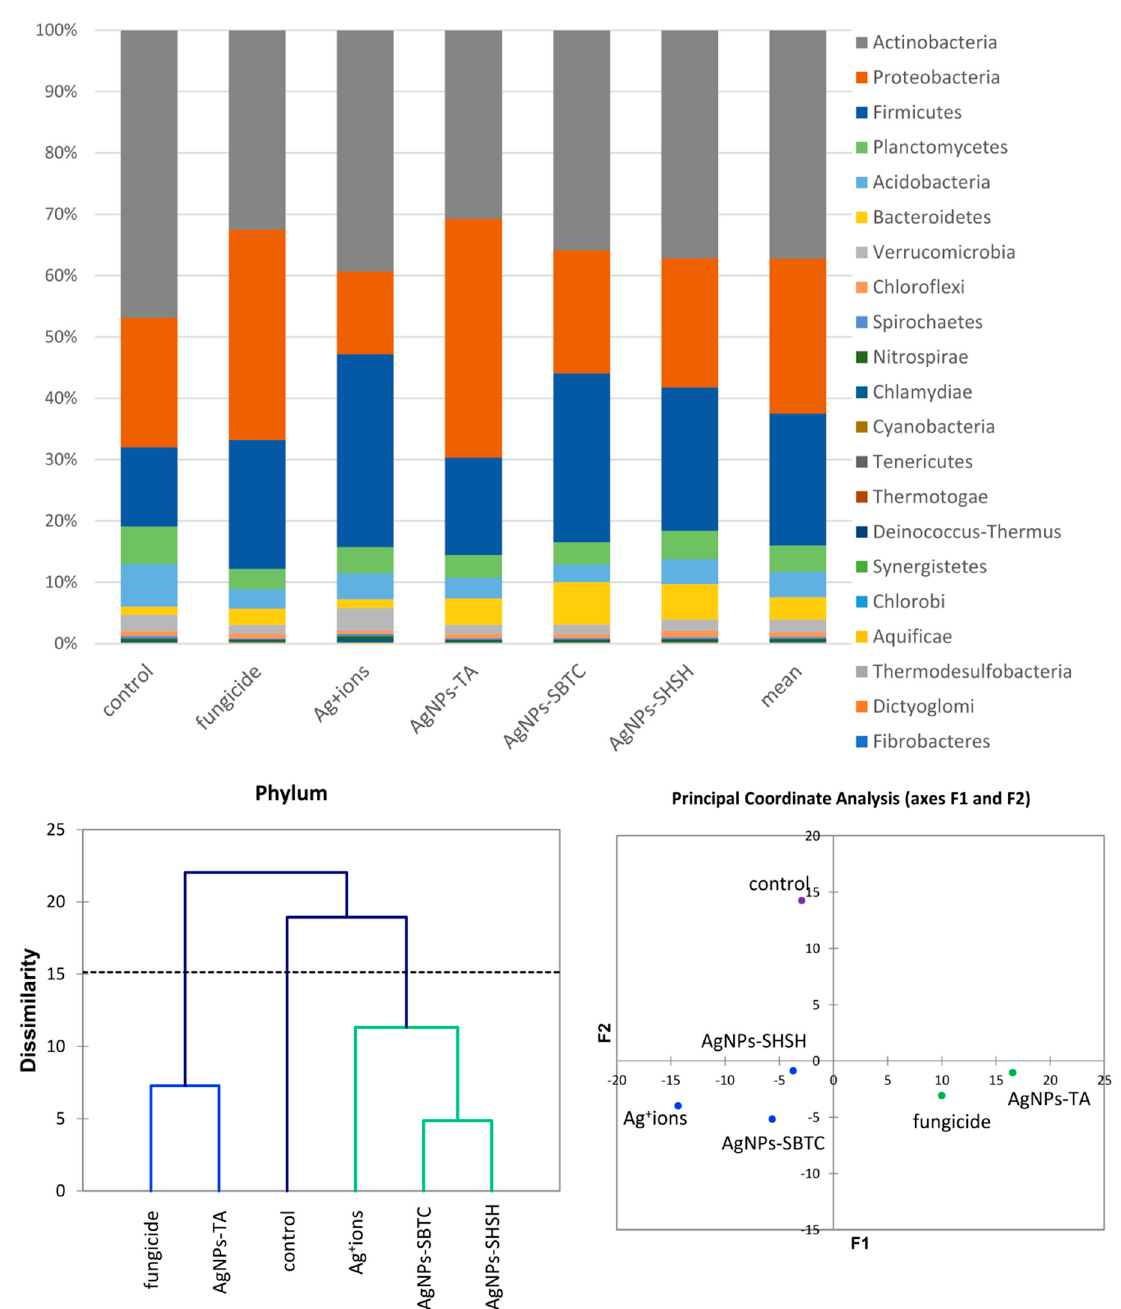
Figure 3. The structure of bacterial communities in treated soils on the level of phylum ( top ), Genetic dissimilarity between phyla represented by Agglomerative Hierarchical Clustering analysis (Bray- Curtis method) for the soils examined in the experiment ( bottom left ), and the relationship between the most abundant phyla depending on the treatments according to PCoA ( bottom right ).